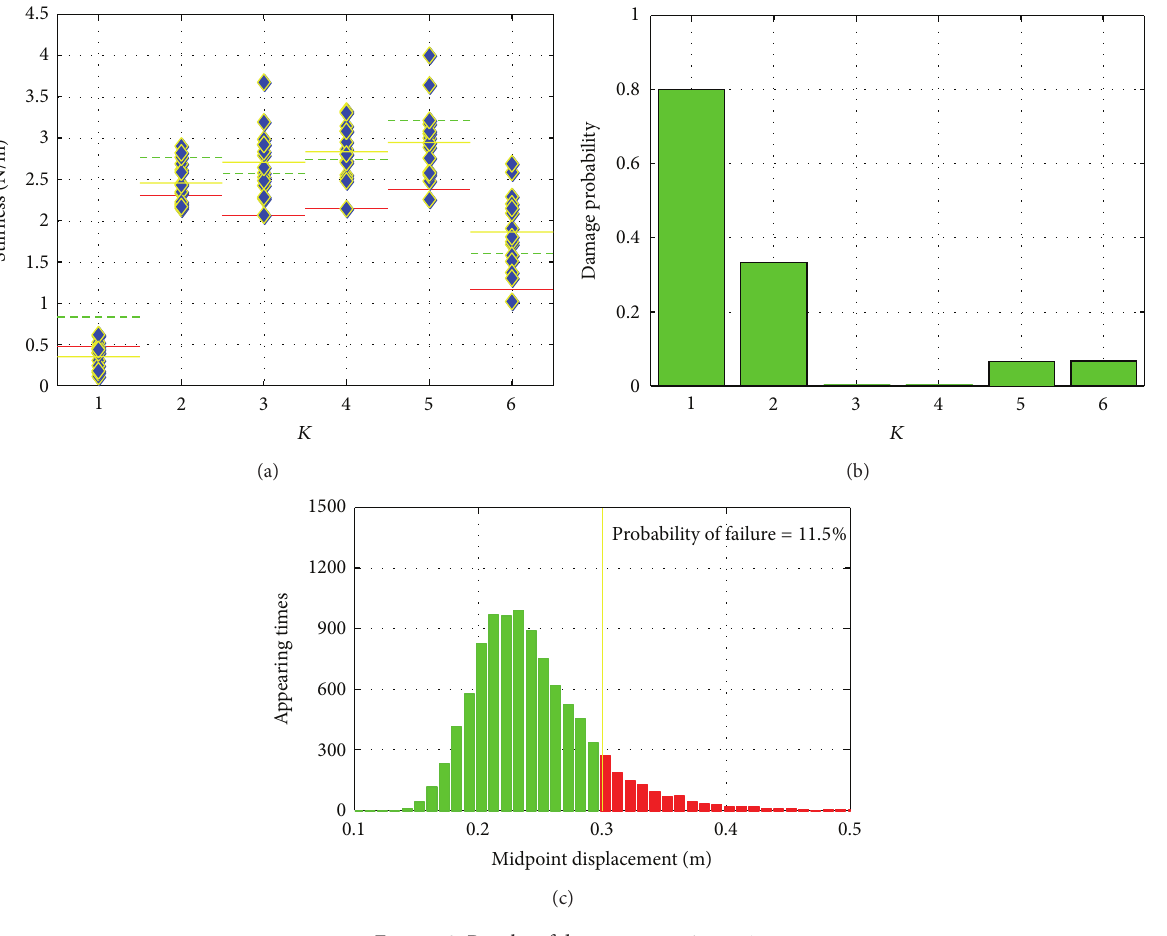
Figure 8: Results of damage scenario no.